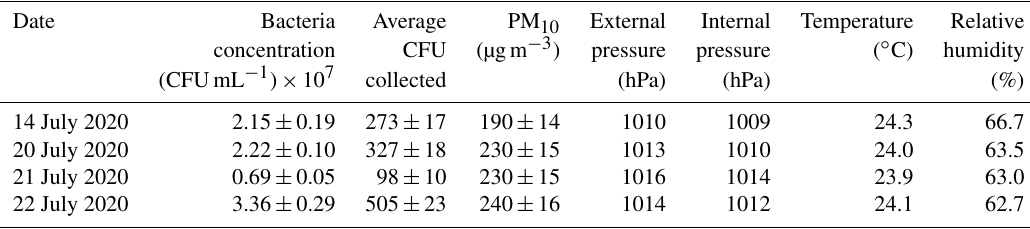
Table 4. Bacteria concentration in the aerosolized solution, average number of colonies counted on the petri dishes, and the meteorological parameters ( P , T , RH) in ChAMBRe in the experiments with the Collison nebulizer operated at: liquid feed rate = 0.4mLmin − 1 , volume of injected solution = 2mL, injection time = 4min, and air flow = 3.0Lmin − 1